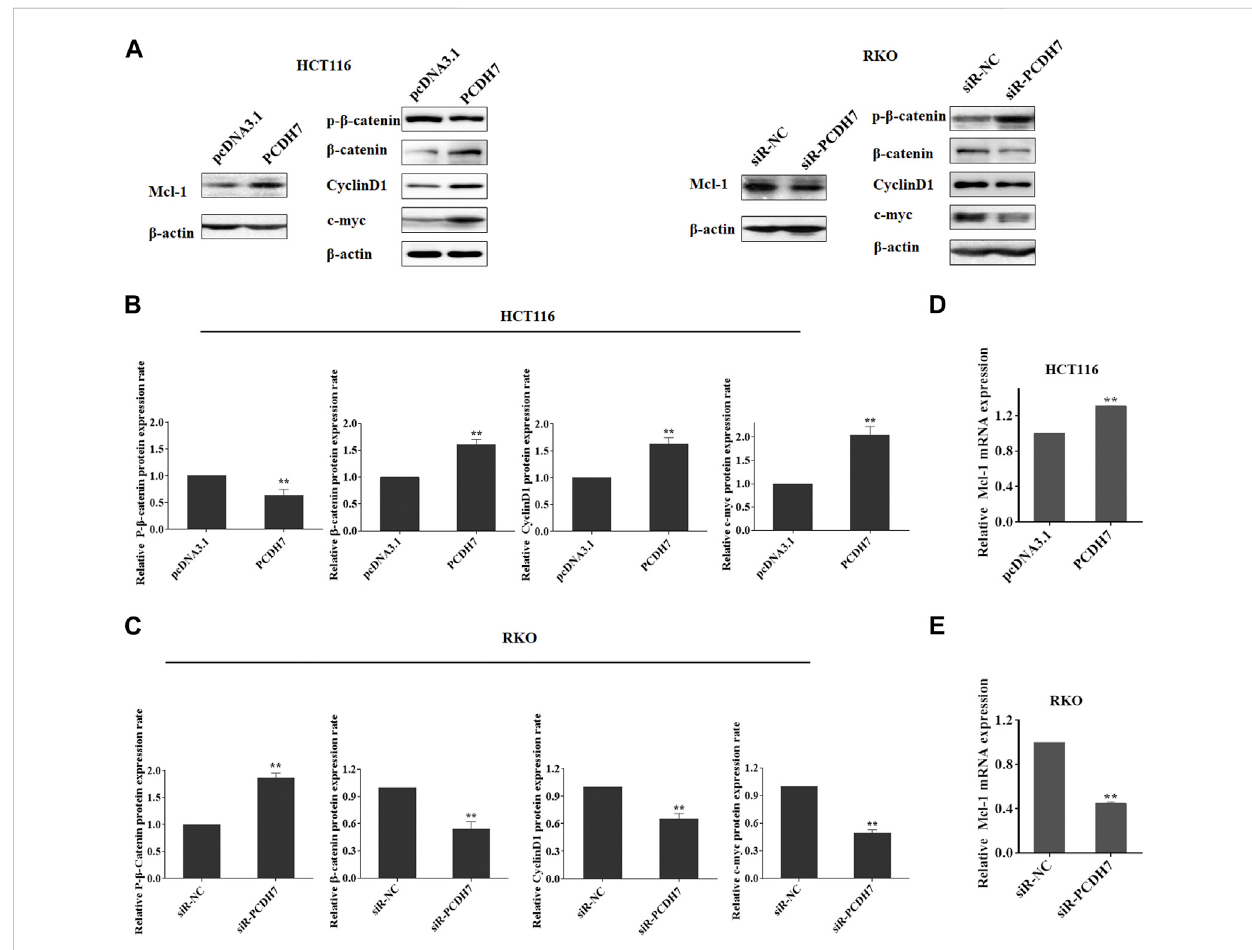
FIGURE 7 Role of PCDH7 in Mcl-1 expression and Wnt/ β -catenin signaling pathway activation. (A – C) Western blot assays were performed to detect the protein expression of Mcl-1, p- β -catenin, β -catenin, cyclin D1, and c-Myc in HCT116 cells with PCDH7 overexpression and in RKO cells with PCDH7 knockdown, respectively. (D, E) Real-time qPCR experiments were performed to detect the mRNA expression of Mcl-1 in HCT116 cells with PCDH7 overexpression and in RKO cells with PCDH7 knockdown, respectively. Data are presented as mean ± SD for three separate experiments. ** p < 0.01 vs.